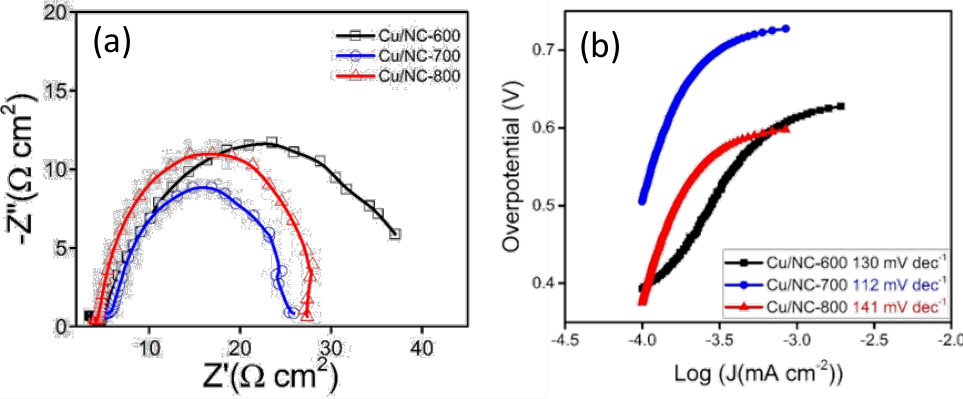
Figure 7. ( a ) Nyquist plots of Cu-NP/NC electrodes in CO 2 saturated 0.5 M KHCO 3 electrolyte. ( b ) Tafel slopes for the Cu/NC electrodes.